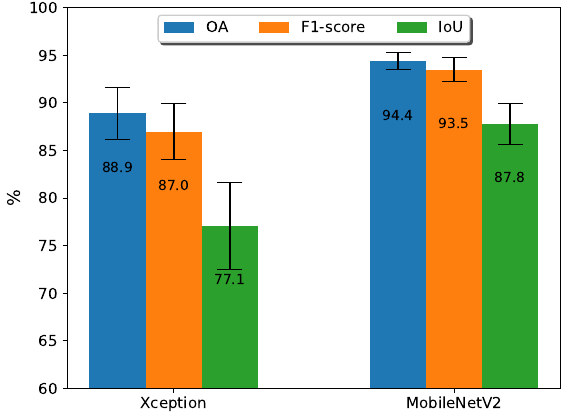
Figure 5. Results for 5-fold cross validation for DeepLabv3+ backbones